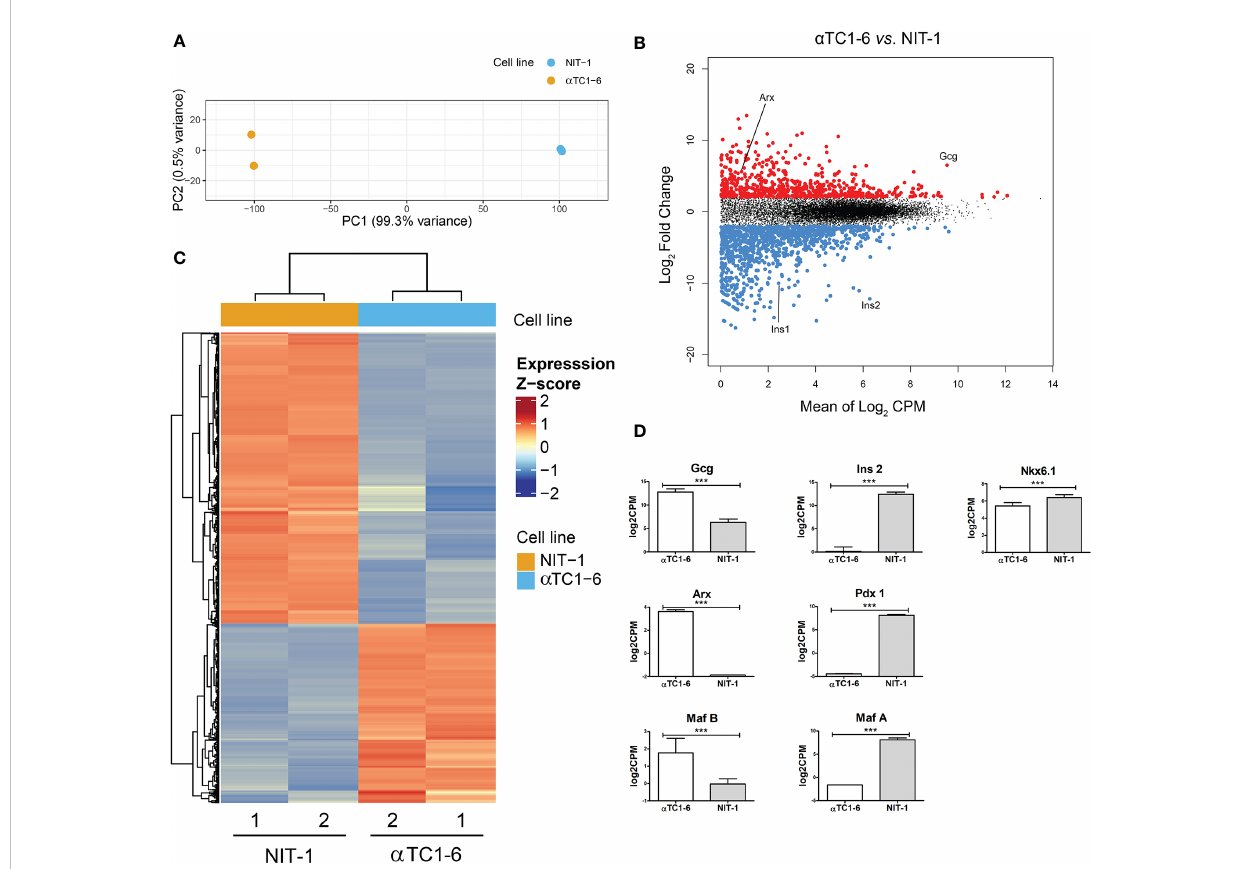
FIGURE 1 Mouse pancreatic alpha and beta cell transcriptome analysis - characterization of a model system. (A) Principal Component Analysis (PCA) of RNA- seq data of an alpha-cell line ( a TC1-6, N=2, blue) and a beta-cell line (NIT-1, N=2, orange) describing >99% of the transcriptional variability at the fi rst principal component (N represents the number of biological replicas). (B) Log ratio vs. mean average (MA) plot of RNA-seq data displays gene- wise log2 fold change of alpha (N=2) vs. beta-cells (N=2) normalized-averaged counts against mean expression values. Signi fi cantly higher (N=654) and lower (N=1061) expressed genes in a TC1-6 vs. NIT-1 cells are highlighted in red and blue, respectively, and display a mean log2 CPM > 0 and a log2 fold change > 0.5 (FDR < 0.05). (C) Heatmaps and dendrogram showing the 1715 signi fi cantly differentially expressed genes between an alpha- cell line ( a TC1-6, N=2) and a beta-cell line (NIT-1, N=2) (see B ). Heatmap displays gene expression z-score in a color scale between blue and red and samples and genes are clustered by Euclidean distance. (D) Expression of selected genes with statistically signi fi cant different expression